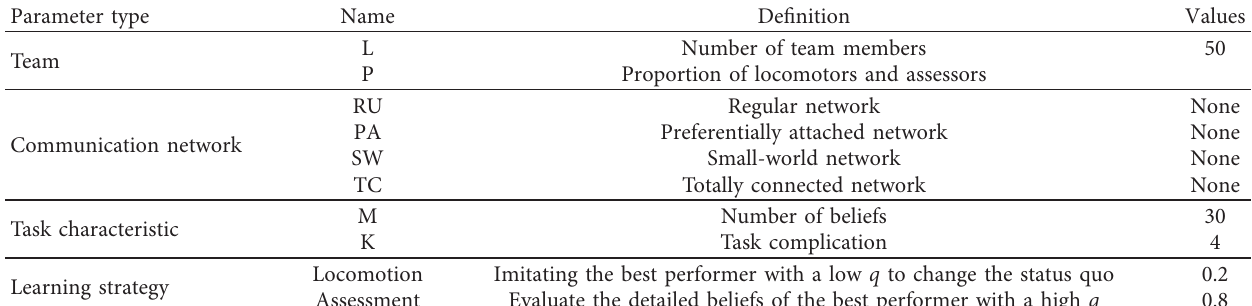
Table 1: Summary of model parameters.